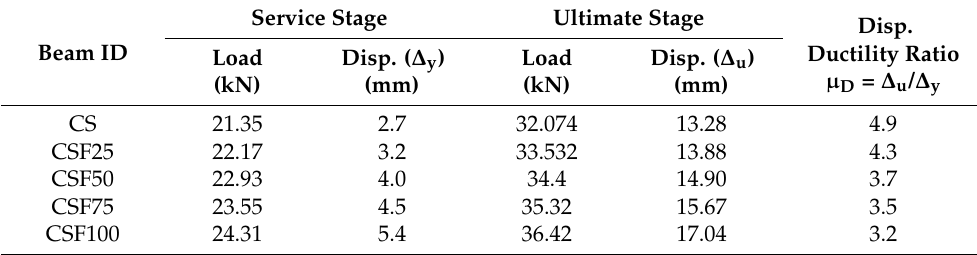
Table 5. The ductility